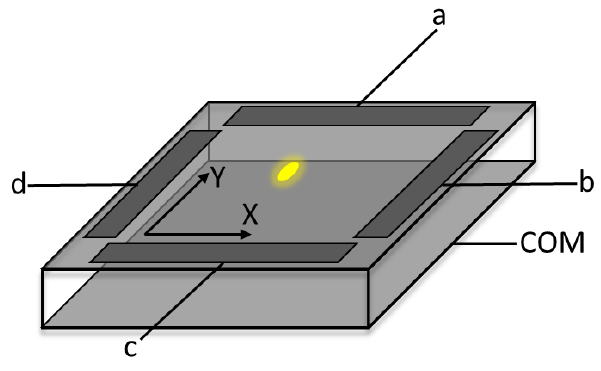
Figure 1. PSD Figure 1. PSD structure.